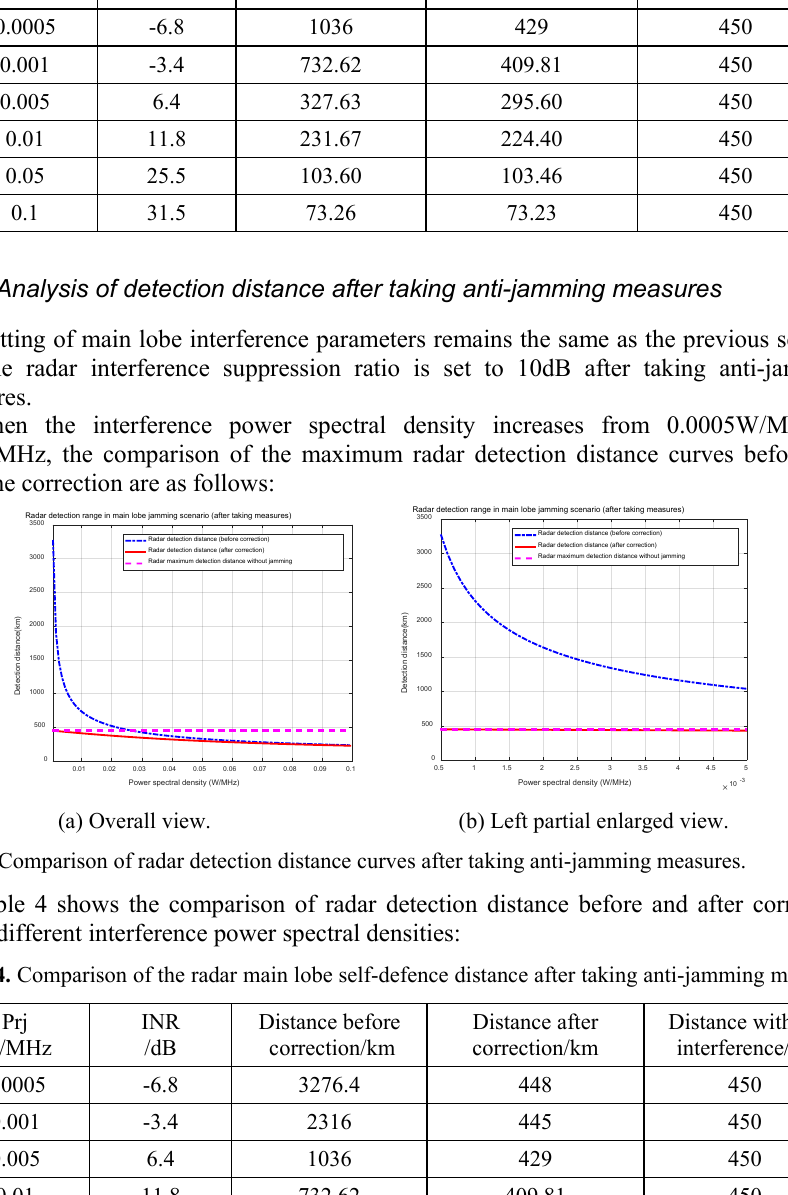
Table 3. Comparison of the radar main lobe self-defence distance before and after correction.